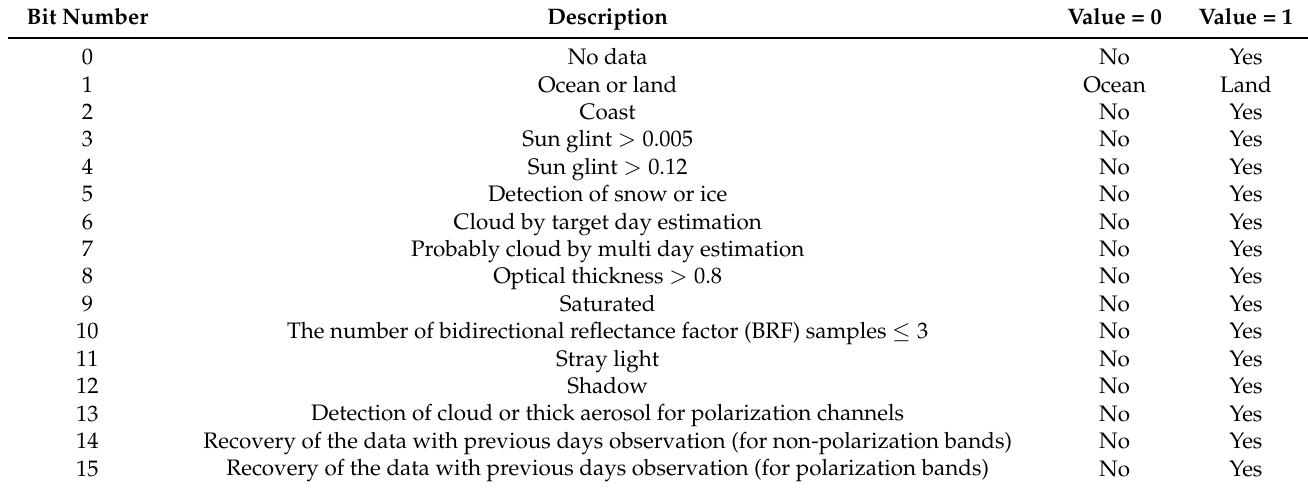
Table 5. The details of the Quality Assessment (QA) flag of the level 2 atmospheric corrected land surface reflectance (RSRF) daily products of GCOM-C/SGLI (version 3) [61]. Bit 0 is the least significant